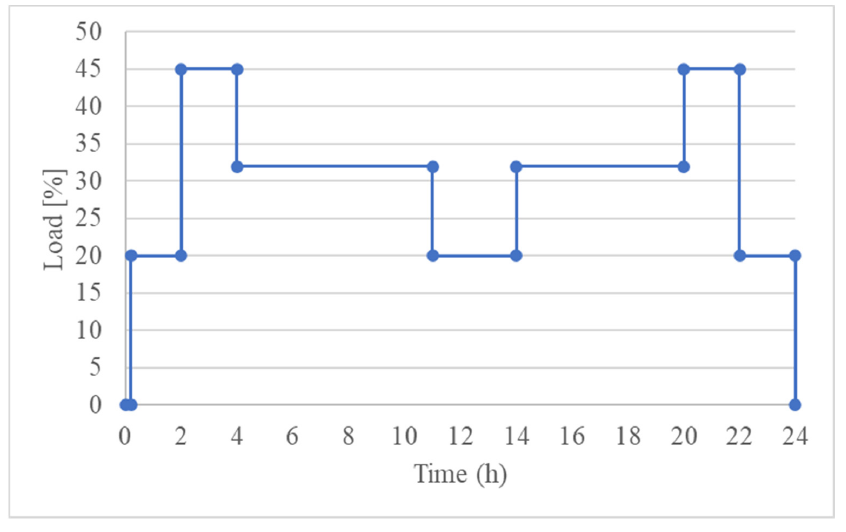
Figure 14. Variation of the stack load for the CHP load profile.